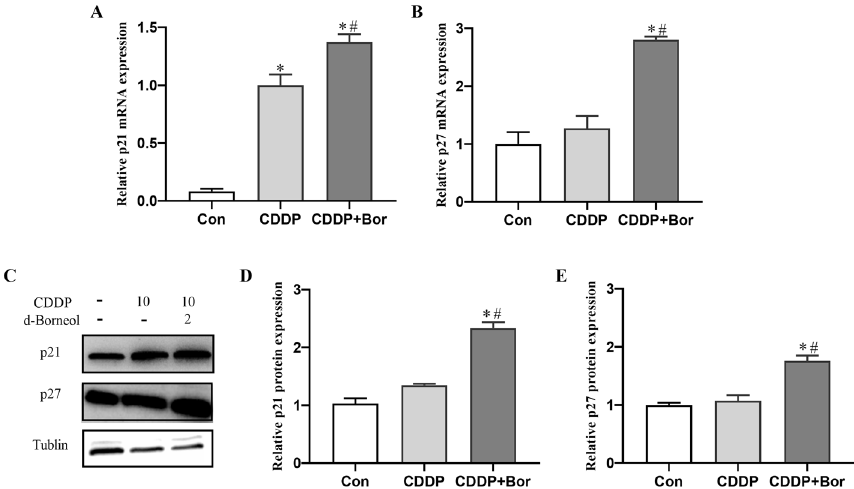
Fig. 5 Expression of p27 and p21 in H460/CDDP cells. A , B mRNA expression level of p21 ( A ) and p27 ( B ) in each group; C – E protein expression of p21 and p27 and their quantification analysis. All data are presented as mean SD ( n 3, * P < 0.05, compared with Con; # P < 0.05, compared with CDDP ± =